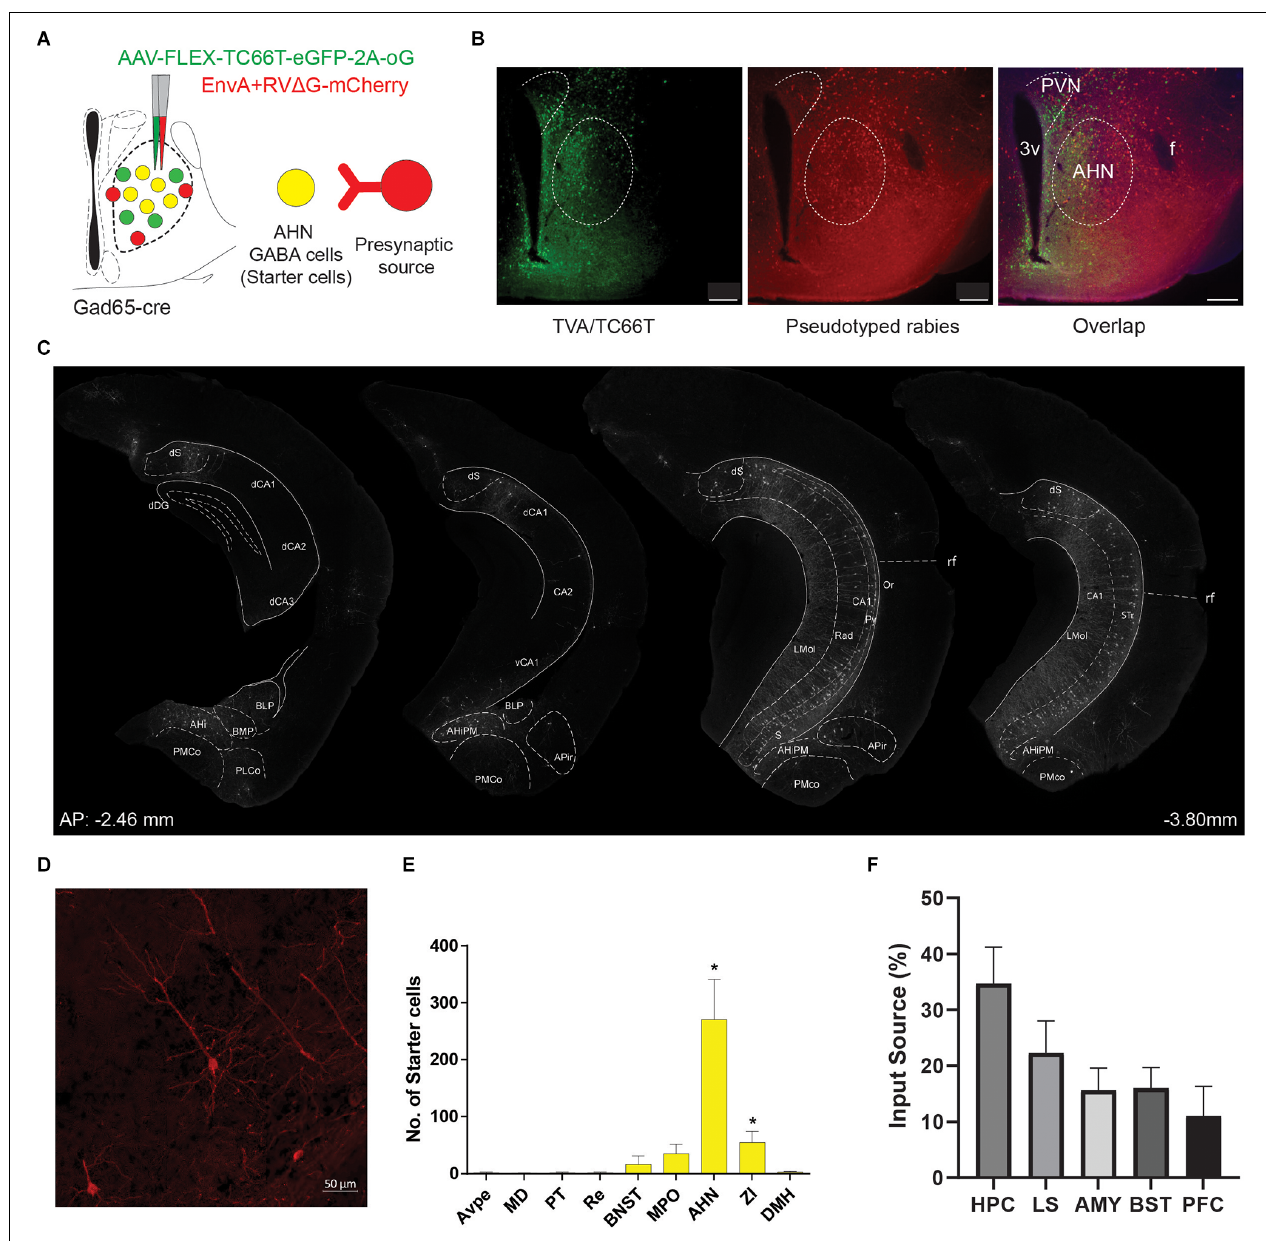
FIGURE 1 | AHN GABA cells receive inputs from the hippocampus. (A) Schematic showing the cell type specific monosynaptic tracing approach. AAV-FLEX-TC66T-eGFP-2A-oG (green), cre-dependent helper virus expresses a via n viral receptor TVA and rabies G in the anterior hypothalamic GABA cells. 2 weeks later, EnvA- ∆ G rabies expressing mcherry infects GABA cells expressing TVA and retrogradely labels one synapse away with the help of rabies G protein. Yellow cells, starter cells express TVA and rabies G and EnvA. Red cells, presynaptic input source that project to the starter cells. (B) A representative section showing localized expression of GABAergic starter cells in the anterior hypothalamus (AHN) shown by expression of AAV-FLEX-TC66T-eGFP-2A-oG (green, left), EnvA-RV ∆ G (mCherry, center), and overlapped expression (green + mCherry, right). Scale bar = 100 µ m. (C) Schematic showing the presynaptic neuron source in the hippocampus from anterior to posterior axis. (D) A representative 40x confocal microscope image of ventral subiculum pyramidal neuron that projects to the AHN GABA cells. (E) Quantification of starter cells ( N = 5). (F) Quantification of the presynaptic input source among limbic structures involved in control of HPA-axis (1-WAY ANOVA, 0.2661 (4,20) = 0.8963, * p = 0.036, Dunnett’s multiple comparisons test, HPC vs. PFC, * p = 0.0139, HPC vs. LS, p = 0.2929, NS, HPC vs. AMY, p = 0.0542, NS, HPC vs. BST, p = 0.0602, NS). 3v, third ventricle; Ahi, amygdalohippocampal area; APir, amygdalopiriform transition area; AVPe, anteroventral periventrivular nucleus; BLP, basolateral amygdaloid nucleus, posterior part; BMP, basomedial amygdaloid nucleus, posterior; BNST, bed nucleus of stria terminalis; dCA1, dorsal cornu ammonia 1 of hippocampus; dCA2, dorsal cornuammonis 2 of hippocampus; dCA3, dorsal cornuammonis 3 of hippocampus; dDG, dorsal dentate gyrus; DMH, dorsomedial hypothalamus (DM); dS, dorsal subiculum; Lmol, lacunosummoleculare layer of the hippocampus; MD, mediodorsal thalamic nucleus; PLCo, posterolateral cortical amygdaloid area; PMCo, posteromedial cortical amygdaloid area; PVN, paraventricular nucleus; PT; Rad, radiatum layer of the hippocampus; rf, rhinal fissure; STr, subiculum transition area; ZI, zona incerta.